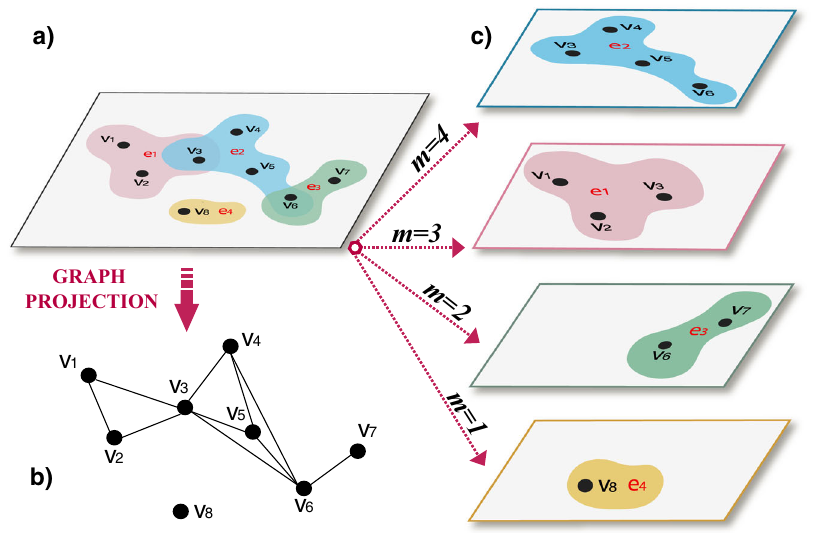
Fig. 1 Graphical representation of a hypergraph. The hypergraph in a , its projection in b , and structural decomposition in c . Mathematically, The set of ; v ; v ; v ; v ; v ; v ; v nodes was represented by V ¼ f v g , while the set of hyperedges was E ¼ f e 1 2 3 4 5 6 7 8 e = { v v v v e = { v v e = { v 2 3 , 4 , 5 , 6 }, 3 6 , 7 }, and 4 8 }. We show how the original hypergraph ( a ) can be represented both by c decomposing it into hypergraphs (color-coded) or by b projection — where hyperedges are simpli fi ed as ∣ e j ∣ -cliques, with j = 1, ...,